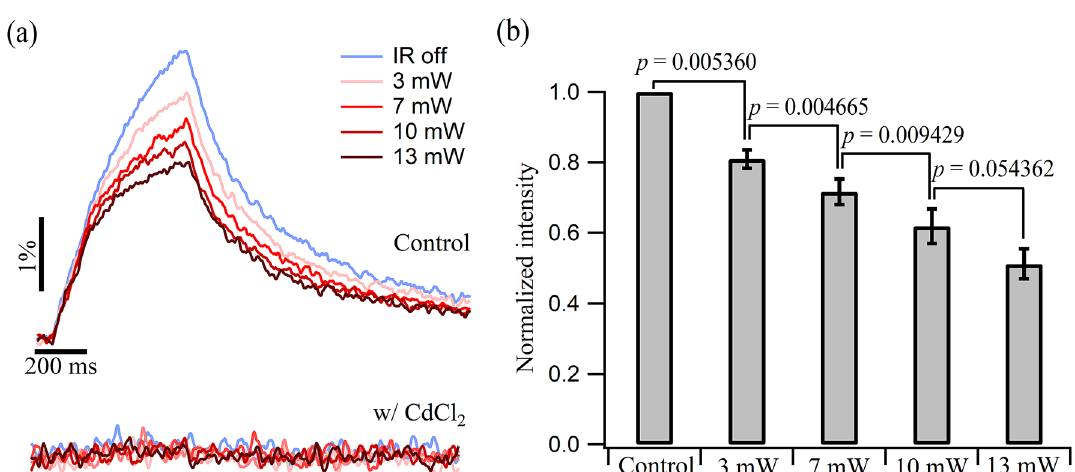
Figure 6. IR light-mediated presynaptic Ca 2+ influx reduction at the axonal terminals. ( a ) Fluorescent recordings showing the AP-triggered terminal Ca 2+ transients in response to a single IR light pulse for four different power levels with control saline (upper panel) and saline containing CdCl 2 (bottom panel). Magnesium Green was used as an indicator of the Ca 2+ ions. The electrical stimulation started at the same time as the IR light pulse, and both had a 500-ms duration. The data was averaged over 50 trials and filtered for presentation. The two panels share the same scales. ( b ) Bar plot showing the reduced fluorescence peak intensity caused by a single IR light pulse with four different power levels ( N =